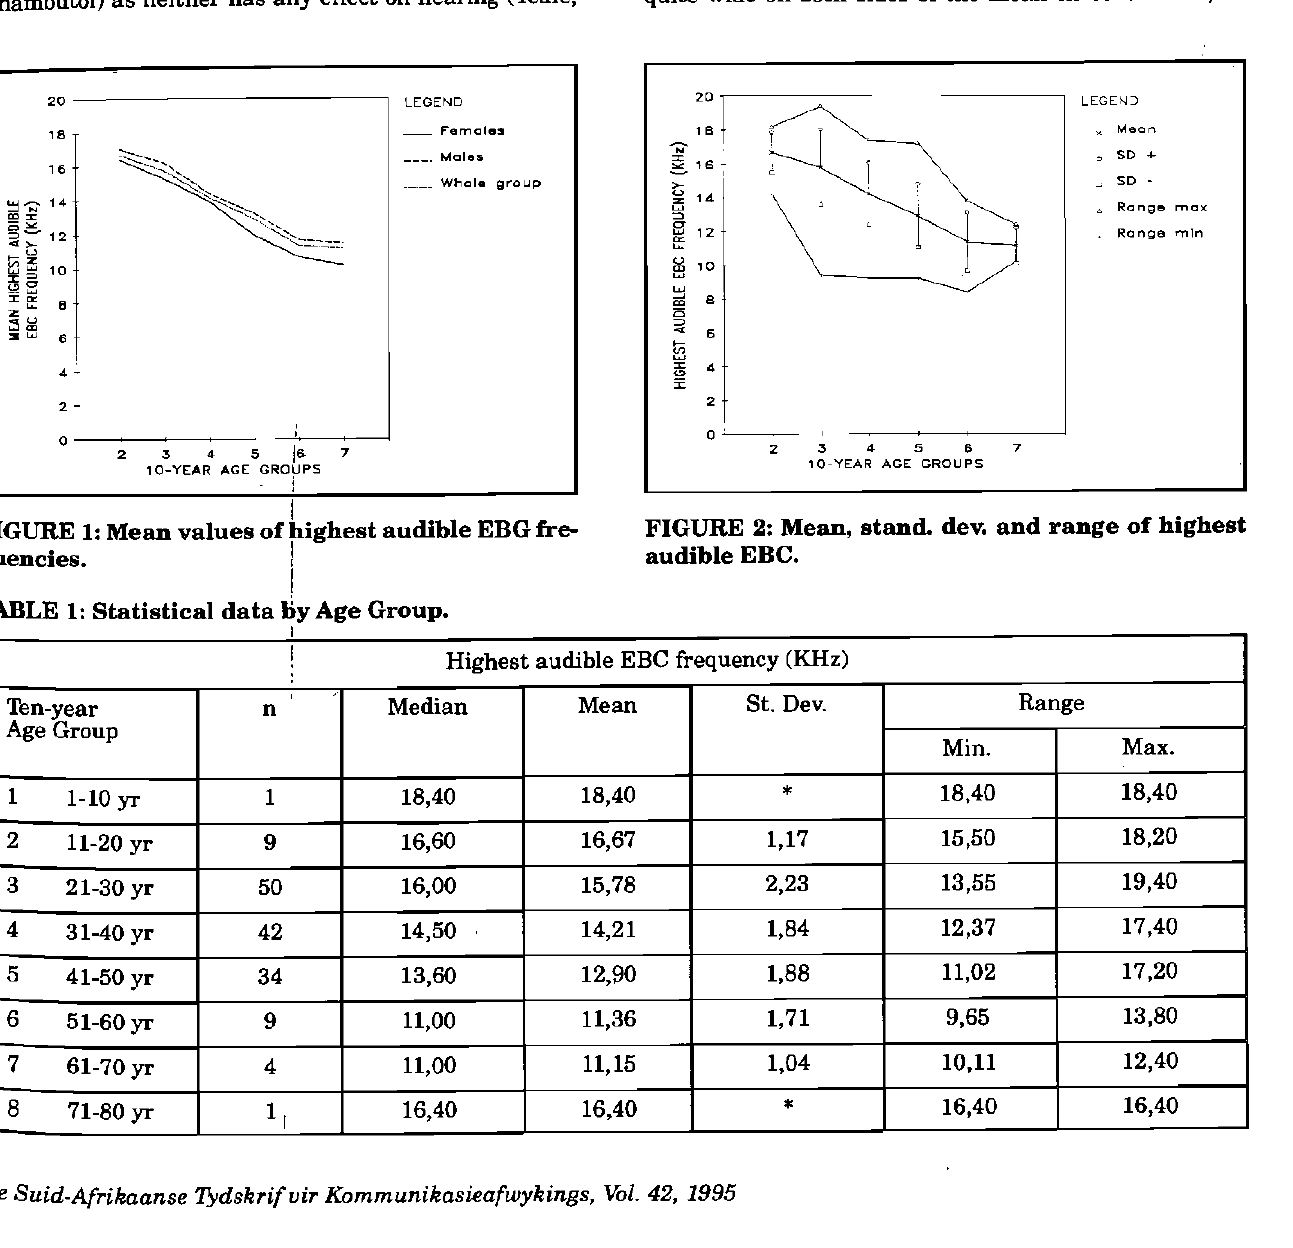
FIGURE 1: Mean values of highest audible EBG fre- quencies. TABLE 1: Statistical data by Age Group.